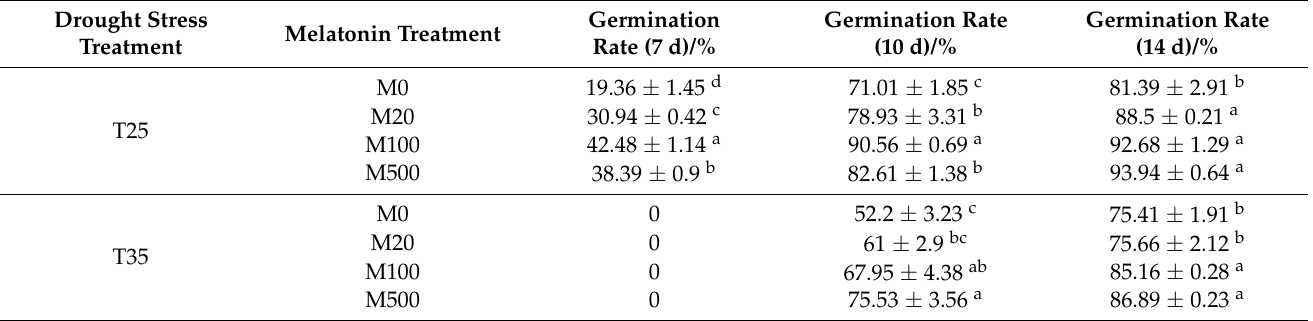
Table 1. Effects of exogenous melatonin on the germination rate of rice seeds under drought stress. Means ± SEs with different letters in each parameter indicate significant differences (LSD, 0.05). Drought